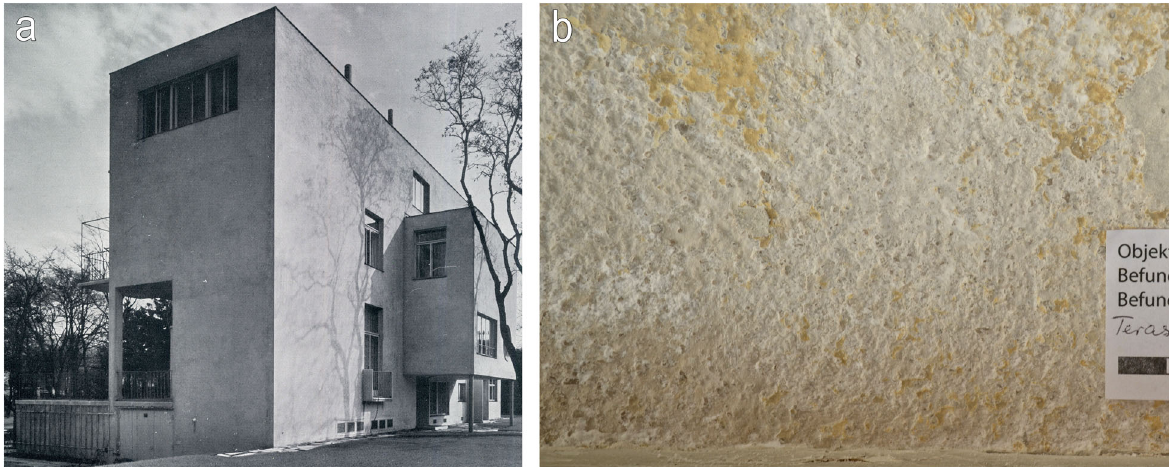
Fig. 17 Josef Frank and Oskar Wlach, House Beer in Vienna-Hietzing, 1930. a: from northwest. On the northern façade, the traces of the facture can be seen: scaffolding borders, irregularities [Source: Julius Scherb, Vienna 1931). b: roof terrace, sunbathing niche, ceiling, original façade surface with remnants of four later overcoats and salt efflorescence, yellowish lime wash pigmented with fine silicates on grated lime plaster (Source: HABEAS